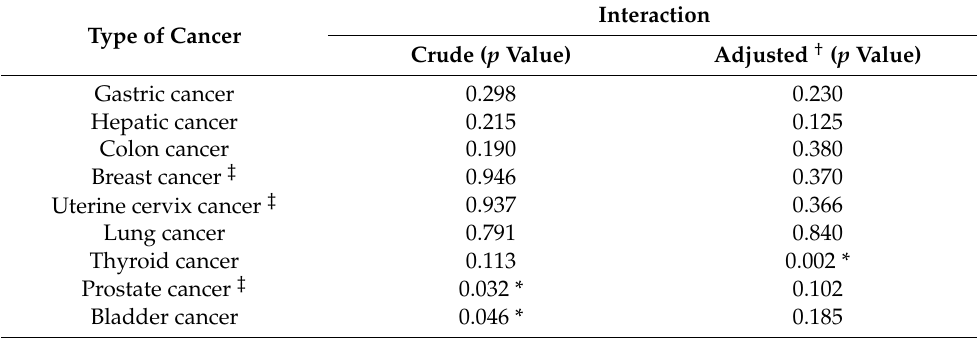
Table 4. The interaction between coffee consumption, and physical exercise for various cancer histories. Interaction Type of Cancer Crude ( p Value) Adjusted † ( p Value) Gastric cancer